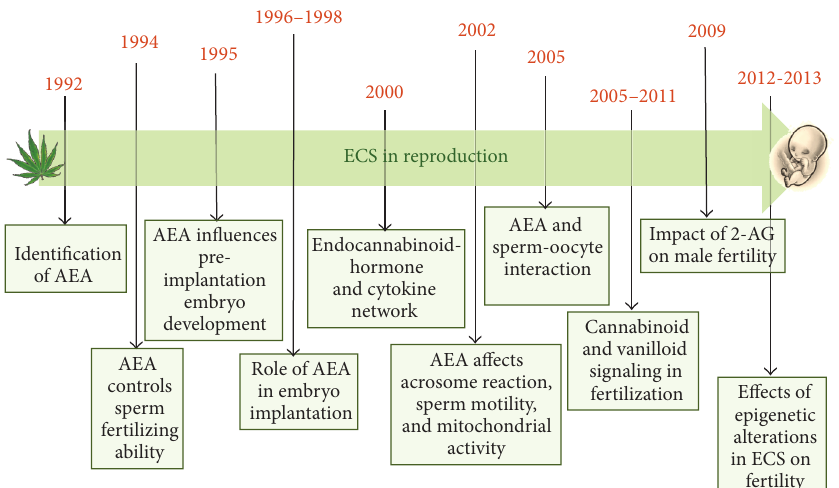
Figure 2: Major breakthroughs in male and fertility